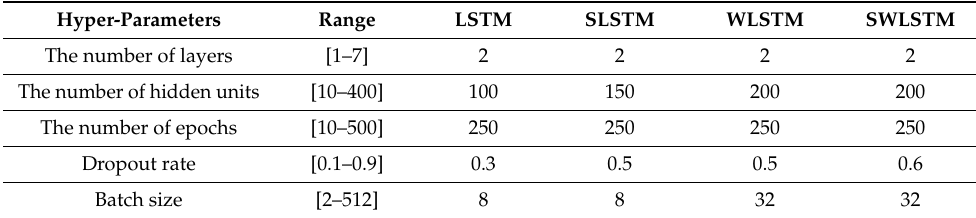
search and K -fold cross-validation with K of 5 (see the rest